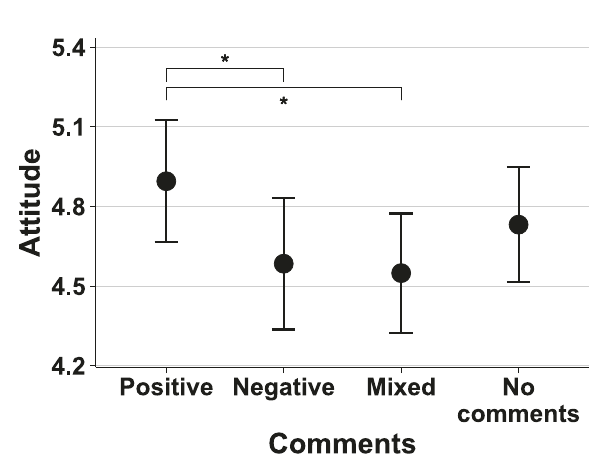
Fig. 2 Main effect of comment sentiment on attitude . Participants viewed news content on a manipulated but ostensibly real social networking site.